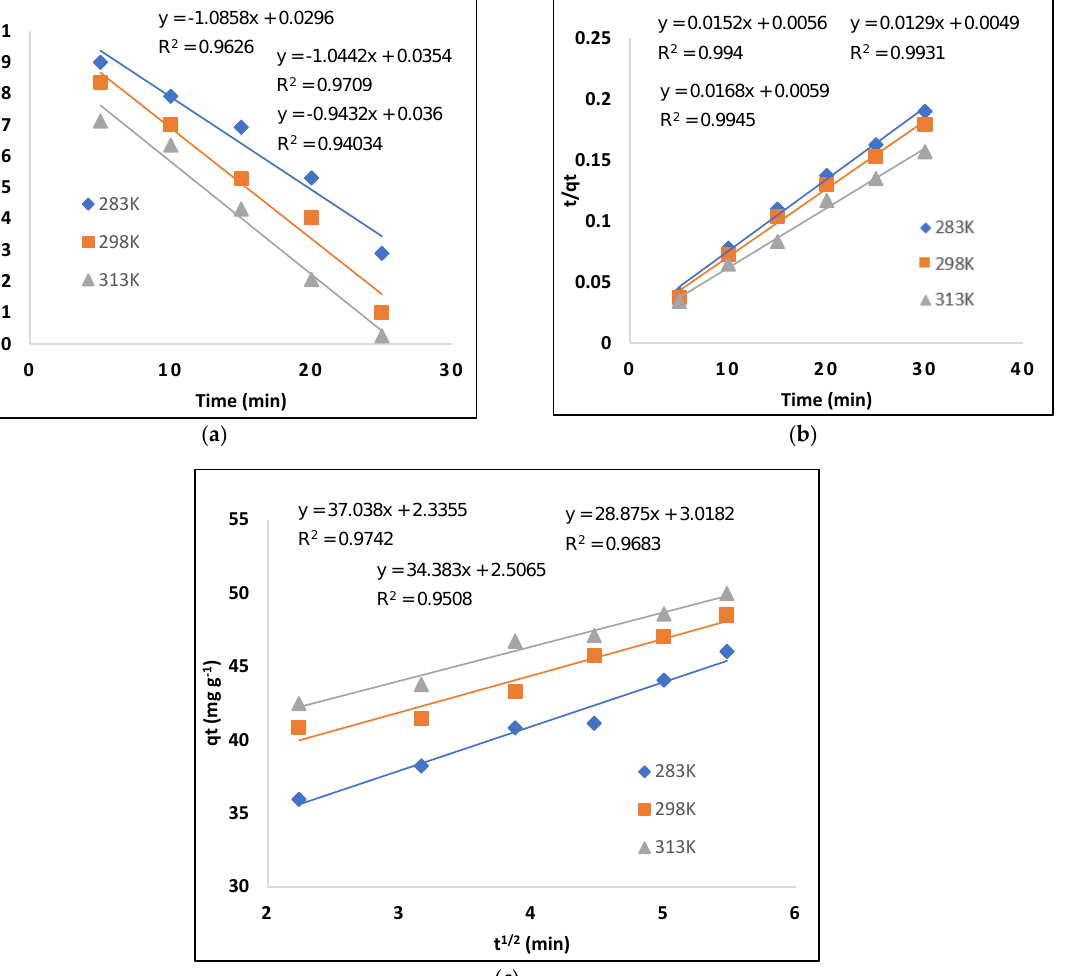
Figure 6. Kinetic model for AB-234 dye adsorption: ( a ) pseudo–first- and ( b ) pseudo–second-order kinetics ( c ) intraparticle models .